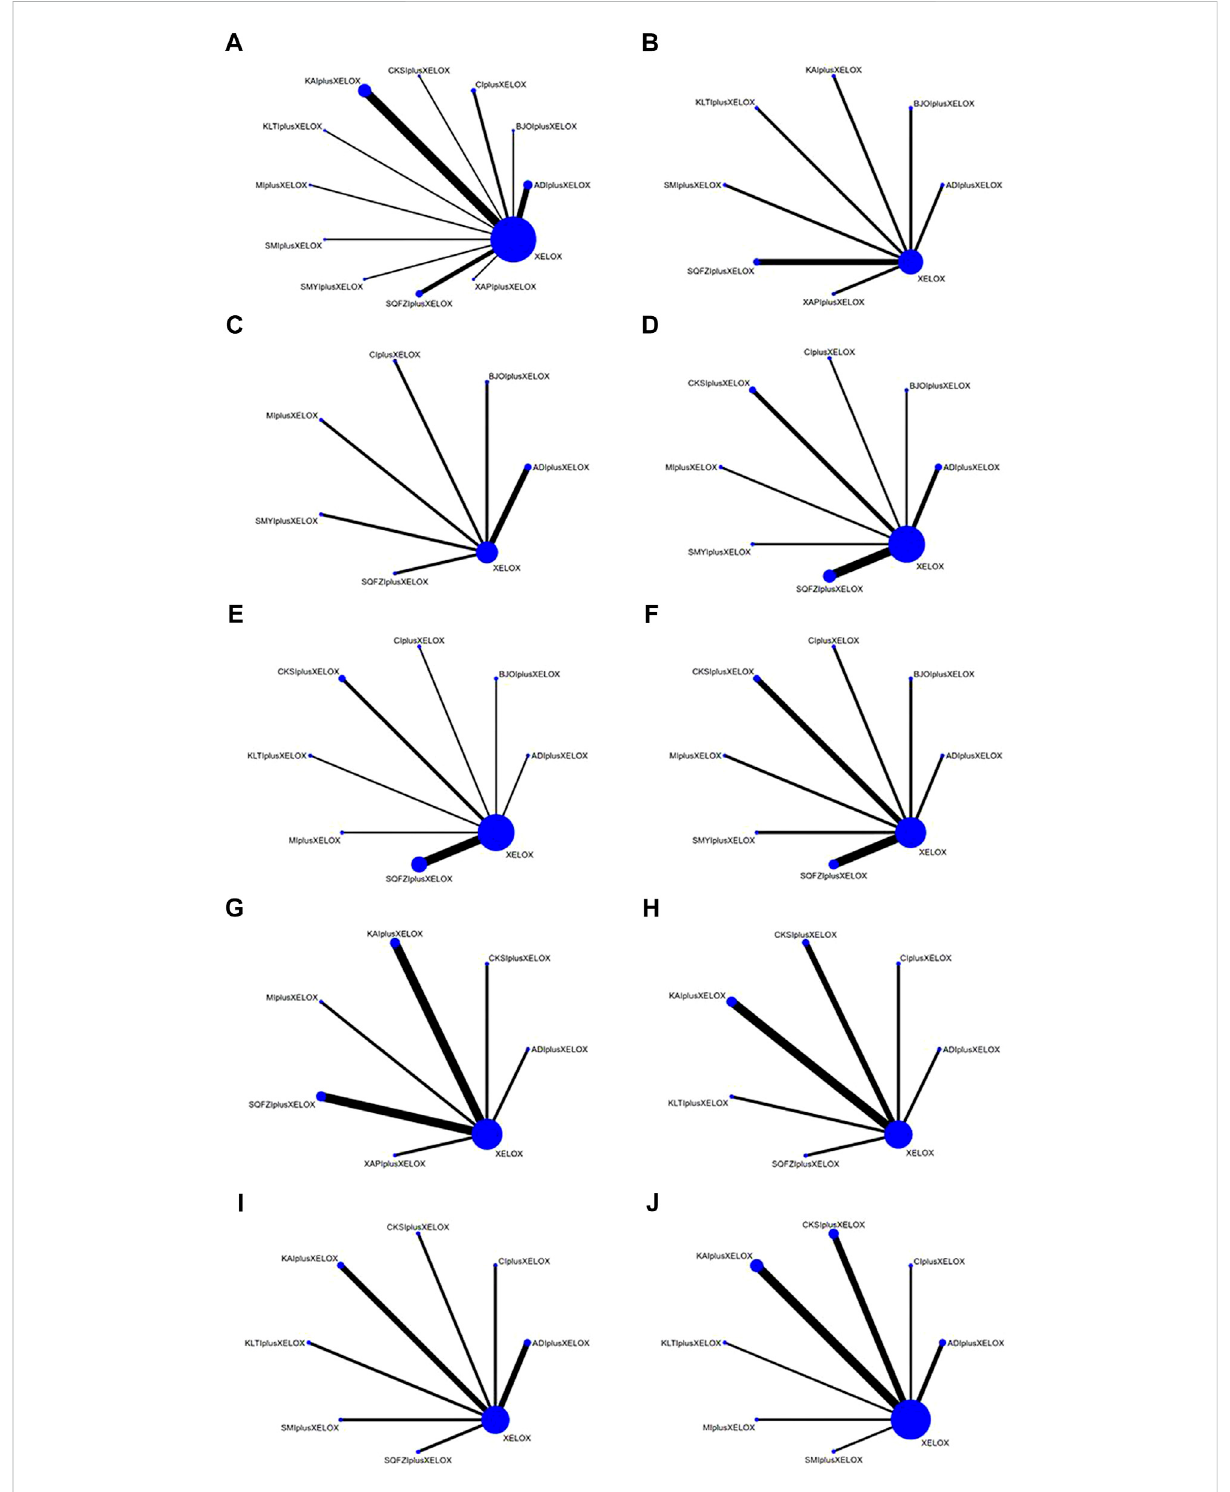
FIGURE 2 Network graphs of outcomes: (A) the clinical effectiveness rate; (B) performance status; (C) CD3 + ; (D) CD4 + ; (E) CD4+/CD8+; (F) CD8 + ; (G) Gastrointestinal reactions; (H) Leukopenia; (I) Platelet decline; (J) nausea and